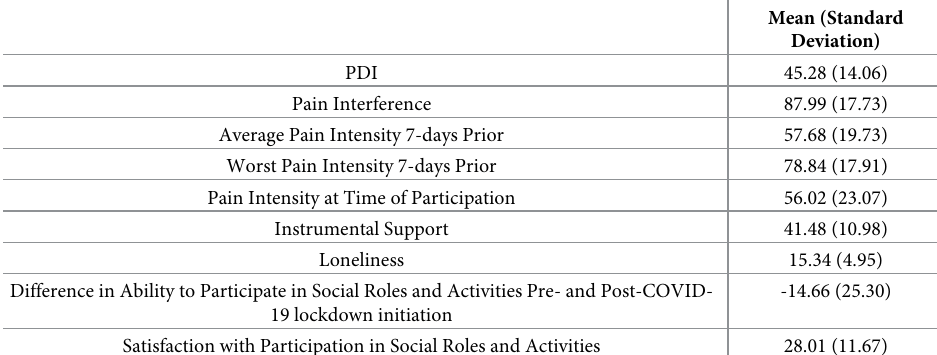
Table 2. Mean values and standard deviations for all outcome and predictor